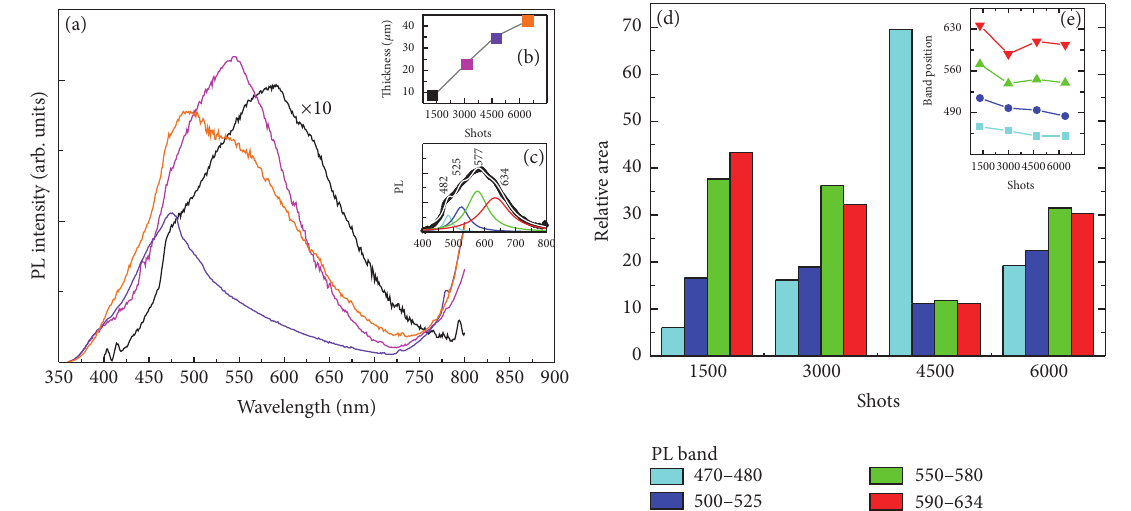
Figure 6: (a) Photoluminescence response of the deposited films, (b) film thickness evolution, (c) deconvolution of the PL spectra of the film prepared with 1500 shots, (d) relative area of the PL bands, and (e) PL band